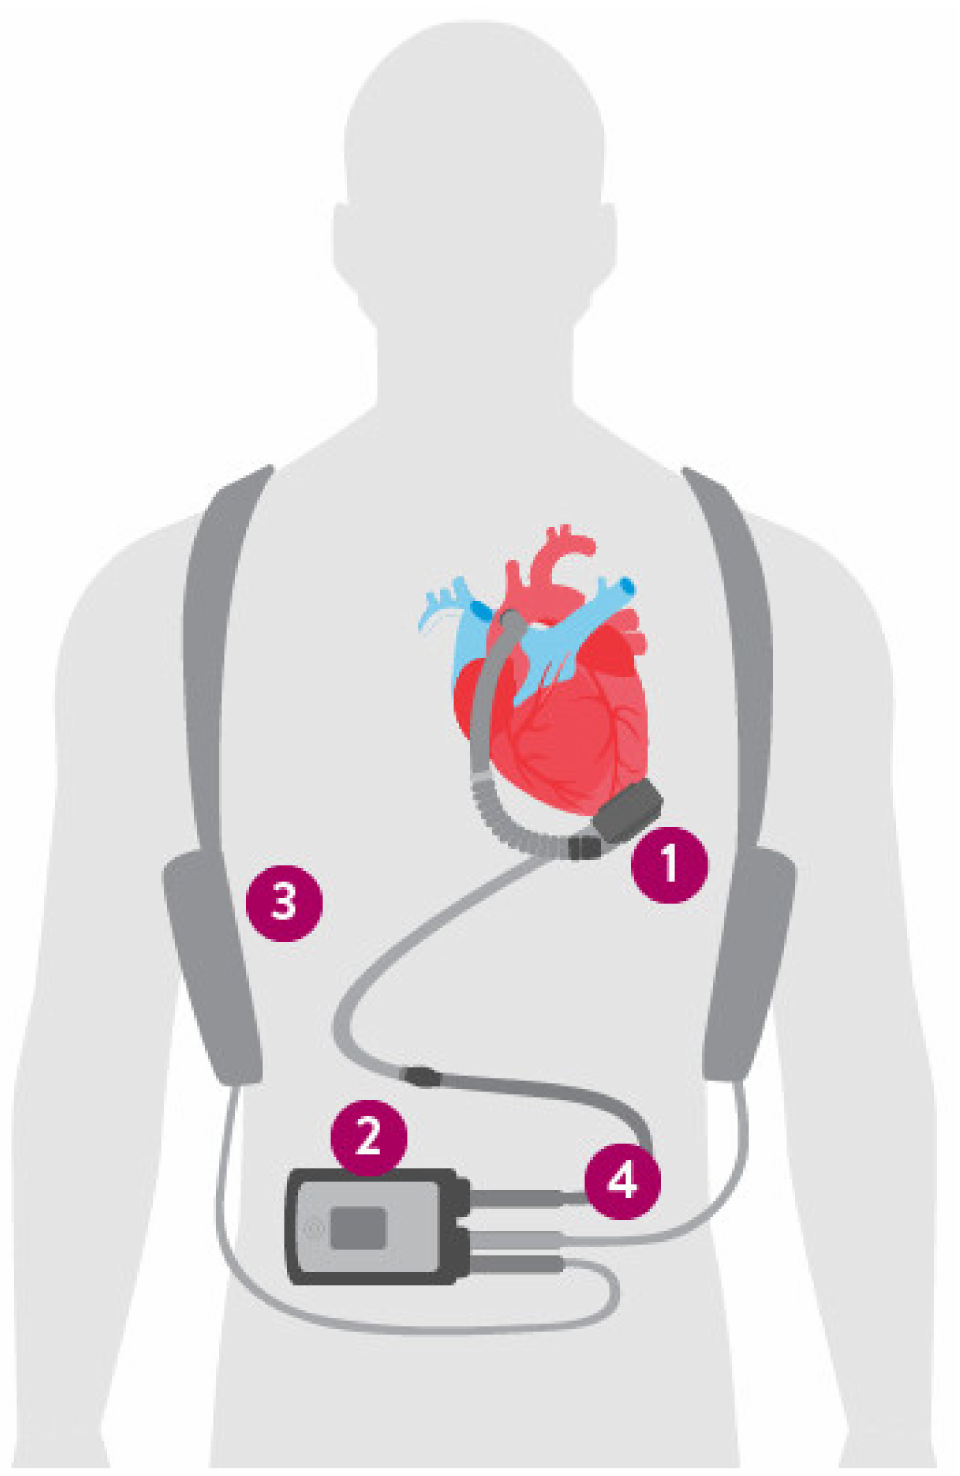
Figure 1. Contemporary LVAD device. Left ventricular assist device (LVAD) with full magnetic levitation with patient peripherals shown. The rotor pump is implanted on the left ventricular apex with outflow graft directed to the aortic root ( 1 ). A controller unit is typically worn on the belt and displays device settings, status, and alerts/alarms ( 2 ). The controller is connected to two portable battery packs ( 3 ), shown here suspended on the shoulders. The controller is attached to the LVAD via a driveline ( 4 ) that typically exits the skin in the upper abdomen and is covered with a sterile dressing at all times. (Image reprinted with permission from Abbott